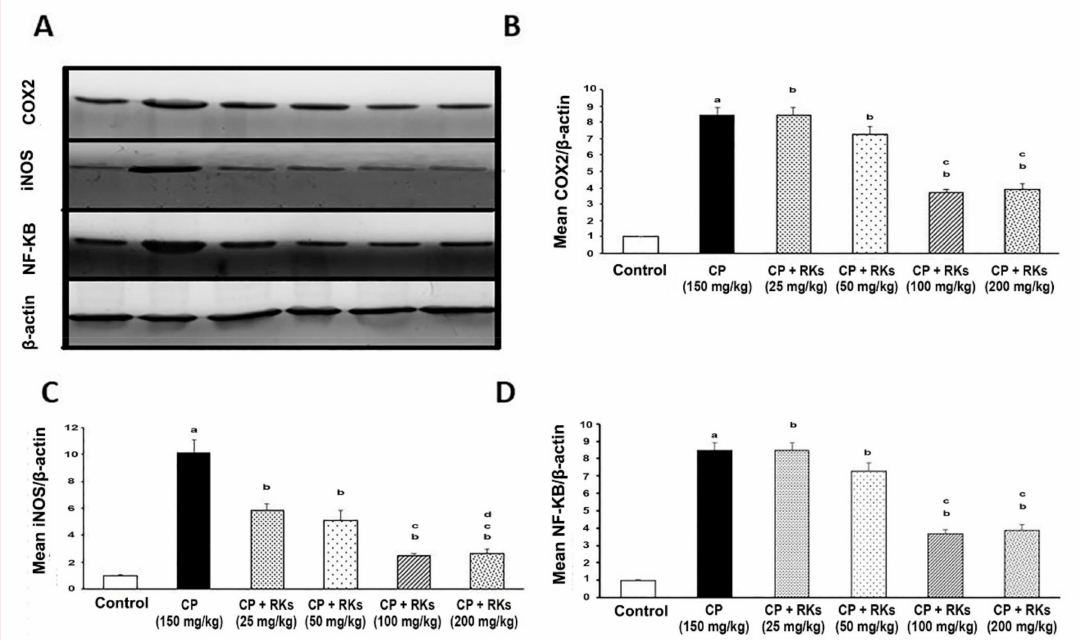
Figure 5. Western blot analysis of NF-KB, iNOS, and COX-2 expression in the lung tissues of male mice treated with RKs against CP. ( A ) The lung tissues from di ff erent experimental groups were lysed and the proteins separated by SDS–PAGE and western blotted using antisera against COX-2, iNOS, NF-KB and β -actin was used as a loading control. The bar graphs show quantitative relative levels of ( B ) COX-2 ( C ) iNOS, and, ( D ) NF-KB protein expression for Control, CP (150 mg / kg, i.p.), CP + RKs with di ff erent doses (25, 50, 100, and 200 mg / kg / p.o.). All values are presented as means ± SE ( n = 4–6). Superscript symbols indicate a significant di ff erence at p ≤ 0.05 using one- way ANOVA followed by the Bonferroni s test for multiple comparisons ( n = 3). a Indicates significant di ff erences from + control (Control) mice, b Indicates significant di ff erences from CP, c Indicates significant di ff erences from RKs (25 mg / kg /